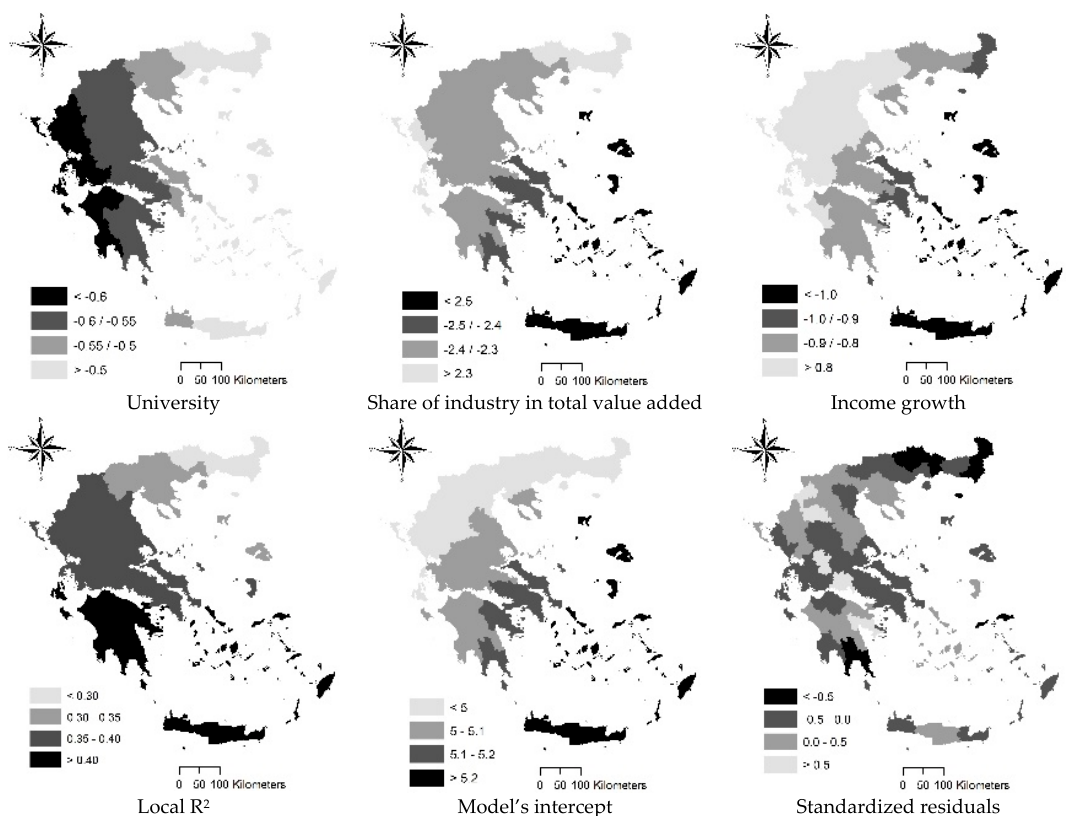
Figure 5. Geographically Weighted Regression with the gender gap (years) in the mean age at marriage (2017) as dependent variable and contextual variables as predictors.